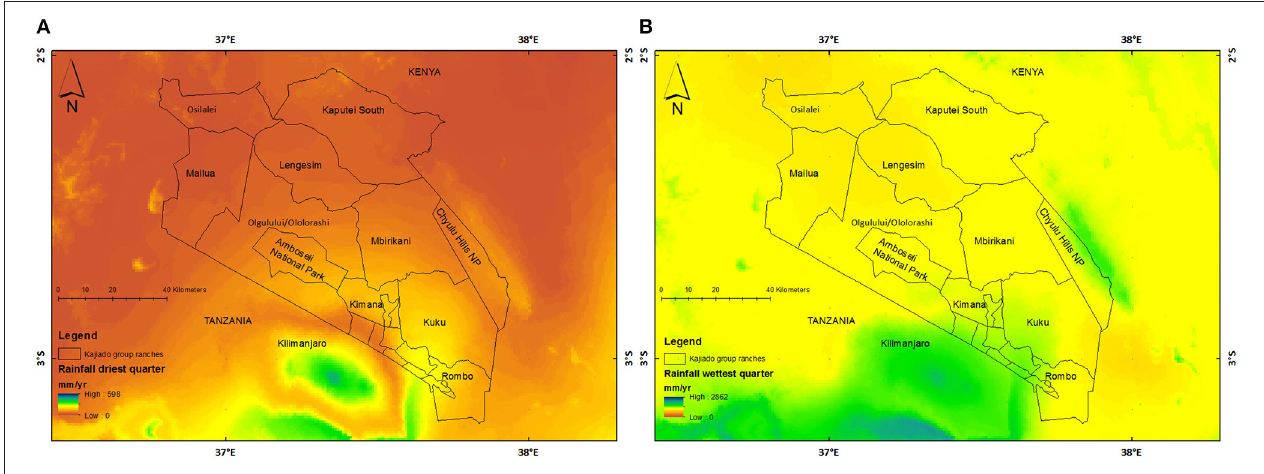
FIGURE 5 | Rainfall driest quarter (A) and rainfall wettest quarter (B) in Kajiado County. The data is derived from WorldClim and it includes any consecutive 3 months of the year. (https://www.york.ac.uk/environment/research/kite/resources/#citation). In the driest quarter (A) , areas near Mt. Kilimanjaro and the eastern side of Amboseli National park are wetter than other parts of Amboseli. These areas have been dry season grazing reserves for both wildlife and livestock but are now challenged with agricultural encroachment and habitat fragmentation. In the wettest quarter (B) , a rainfall gradient is observed in the Amboseli area with the eastern areas being wetter than the western